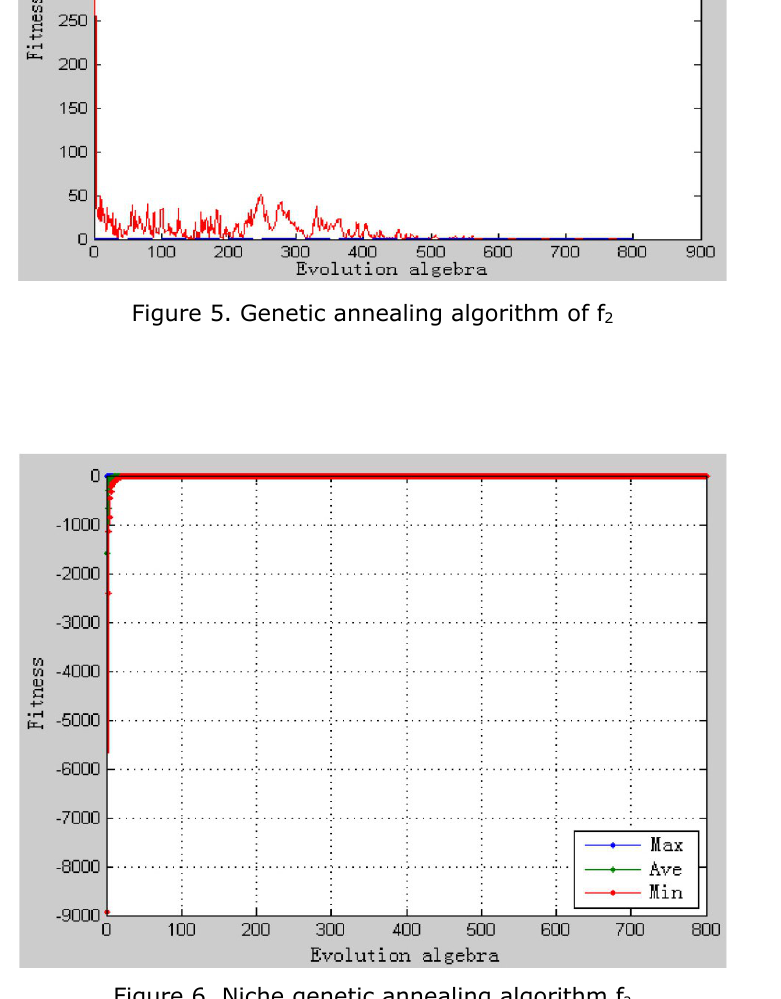
Figure 6. Niche genetic annealing algorithm f